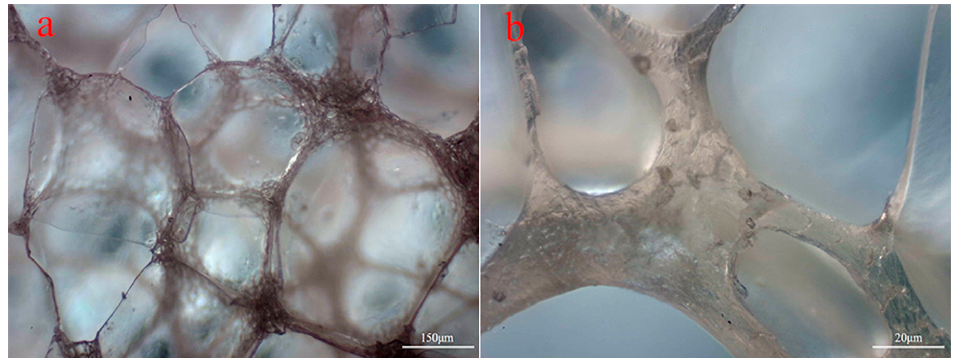
Figure 2. SEM image of as-received ( a ) H75, ( b ) H160, and ( c ) H250 PVC foams.